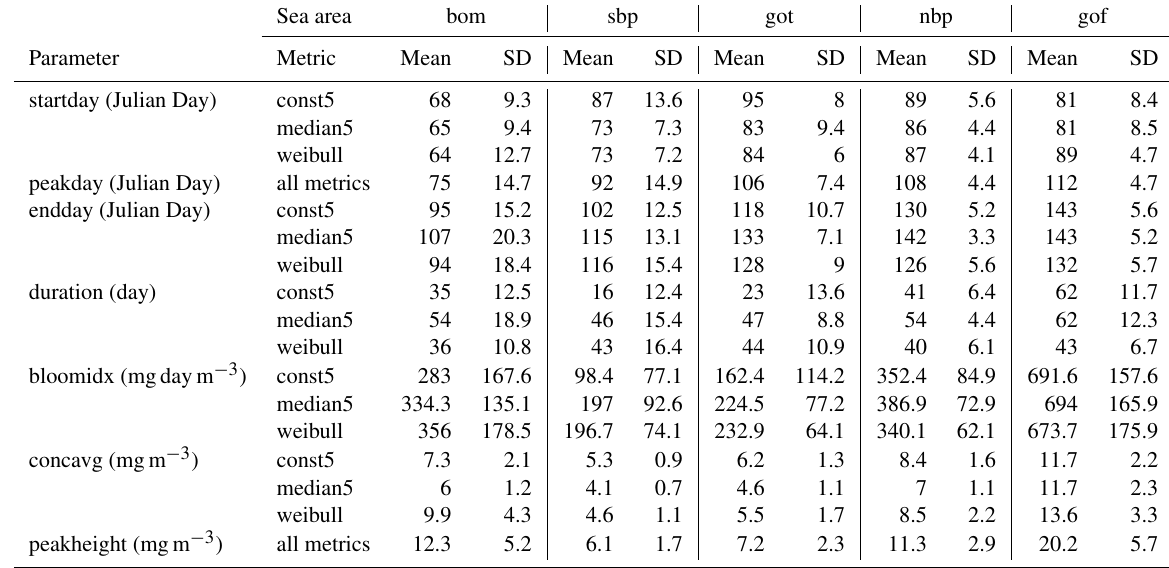
Figure 3. Diurnal variability in the chlorophyll a fluorescence yield: (a) normalized (division by transect-mean) chlorophyll a fluorescence observations plotted against time of day, and (b) sun elevation angle. The analysis was carried out on three subsets: winter (November– February), summer (May–August), and transition periods (March, April, September, October), using all ferrybox observations along the routes shown in Fig. 2. Table 3. Bloom timing and intensity for each investigated sea area (Fig. 2) and for all applied bloom metrics. SD denotes standard deviation. Sea area bom sbp got